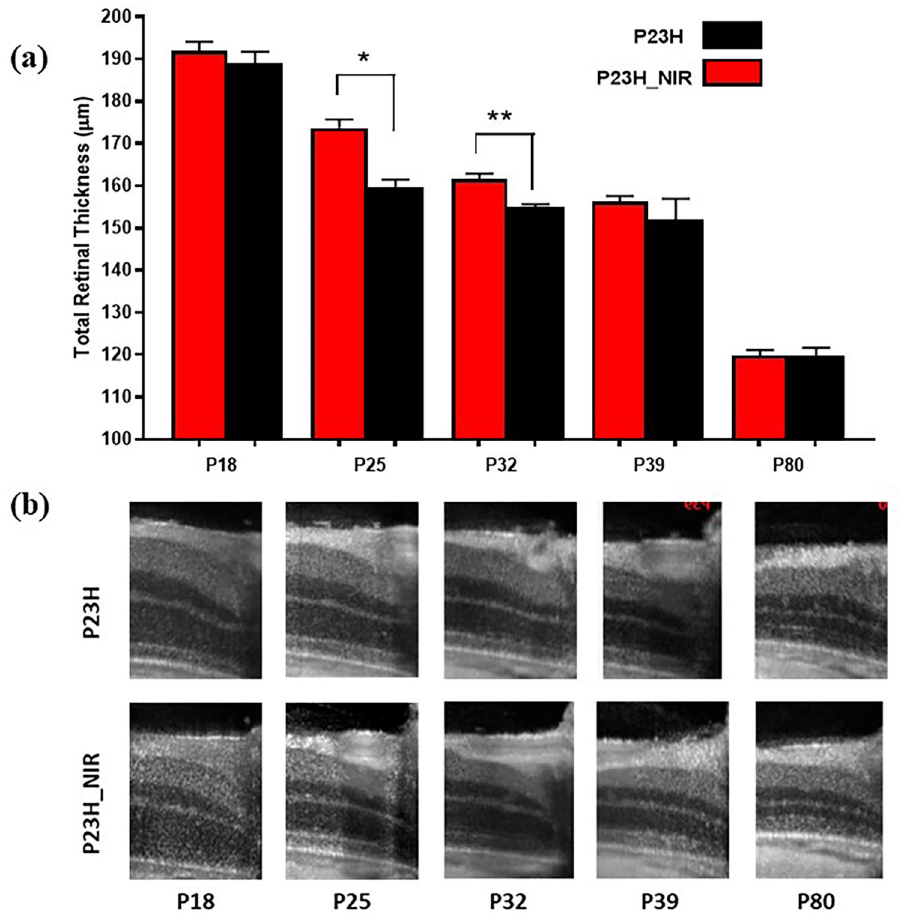
Figure 5. The therapeutic effect of PBM diminishes following the termination of treatment. ( a ) shows the total retinal thickness of 830 nm PBM treated P23H rats and sham-treated P23H rats monitored from p18 to p80 in a longitudinal SD-OCT study. The retinoprotective effects of 830 nm PBM administered from p10–p25 diminished as the animals matured and statistically significant differences ( p < .01) between the sham-treated and 830 nm PBM-treated groups were found at p25 and p32, but not beyond this time. Error bars: SE. ( b ) shows representative linear scans at p18, p25, p32, p39, and